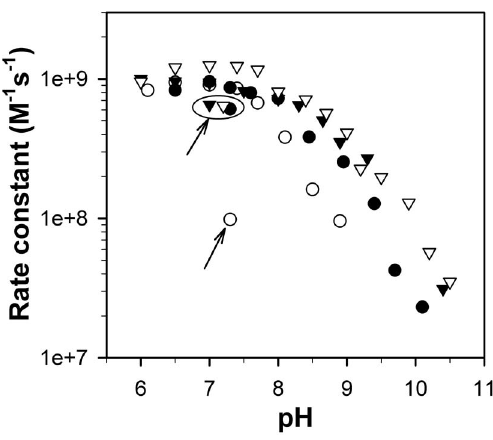
Figure 5. RP-mutant Ca MnSODc is inactivated by heat like Ec MnSOD. Rate constants as a function of pH were determined by fitting the disappearances of low doses of O 2 2 ([O 2 2 ]:[MnSOD] from 1– 3) to first-order processes. The enzymes were Ec MnSOD (grey rectangle), WT Sc MnSOD (solid triangle), K182R, A183P Sc MnSOD (hollow triangle), WT Ca MnSODc (solid circle) and K184R, L185P Ca MnSODc (hollow circle). The data points indicated with an arrow were obtained before the sample solution reached the desired temperature. All other data points were obtained after the sample solution was equilibrated to the desired temperature. The sample solutions contained 1 m M (in Mn) MnSOD in 10 mM potassium phosphate (pH 7), 10 mM sodium formate and 10 m M